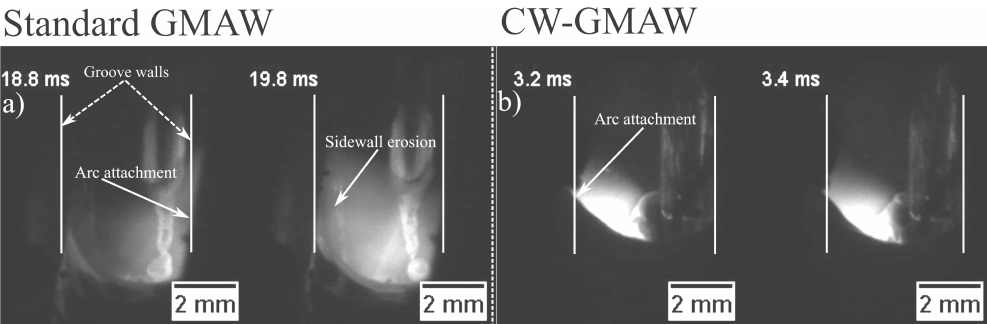
Figure 6. High speed frames, arc dynamic behavior inside the groove: ( a ) standard GMAW; and ( b ) CW-GMAW.